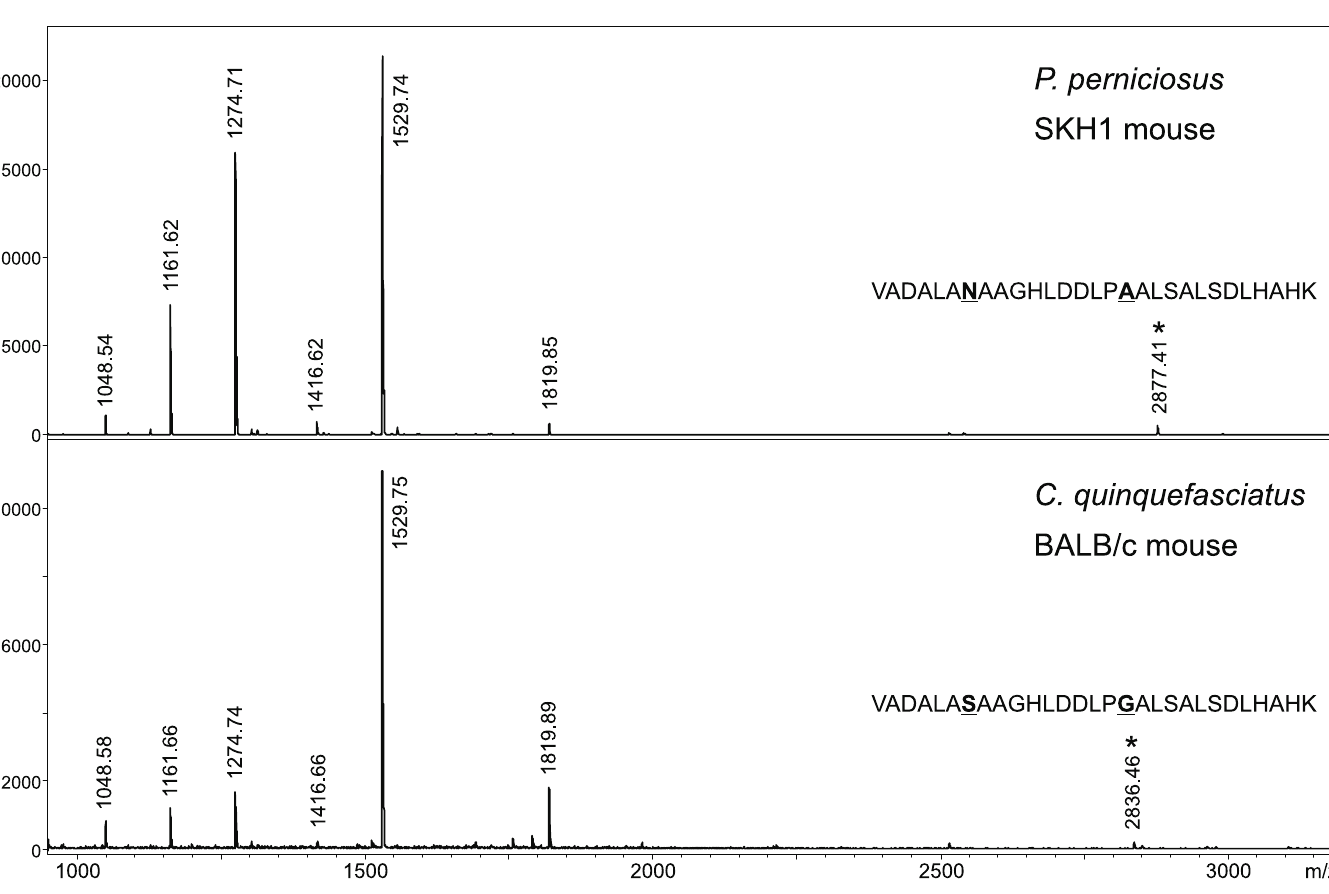
Fig 7. Comparison of abdominal spectra of sand fly ( P . perniciosus ) and mosquito ( C . quinquefasciatus ) females fed on mice. Practically identical MALDI-TOF peptide mass maps were observed for both insects. The only difference was caused by a double mutation within a peptide sequence of HBA (marked by asterisks), which was related to two types of mouse used as a blood source (SKH1 vs. BALB/c). The engorged females were collected 12 h